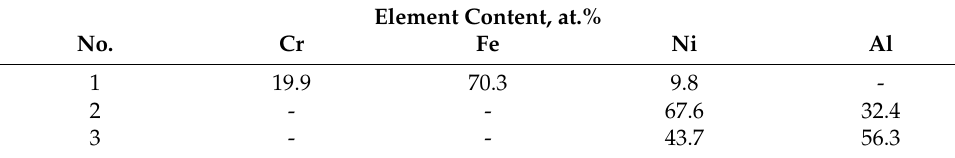
Table 4. EDS analysis results for ampoule No. 2 in according to each point marked in Figure 9a.